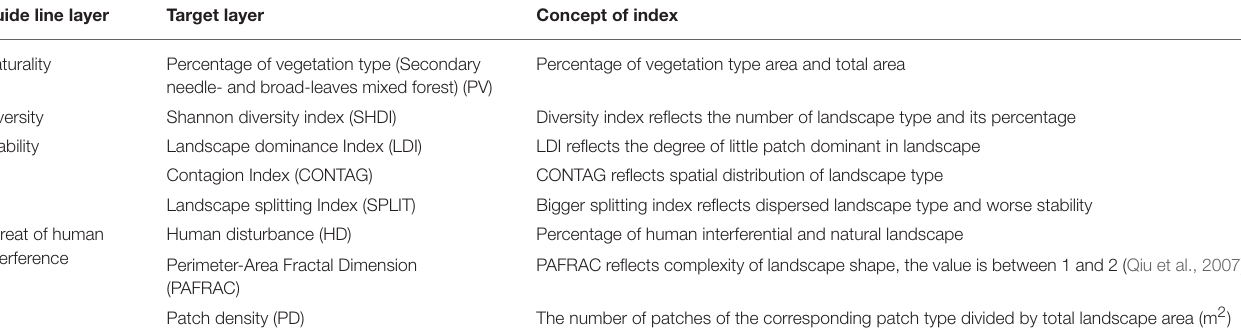
TABLE 3 | Ecological assessment index used in this